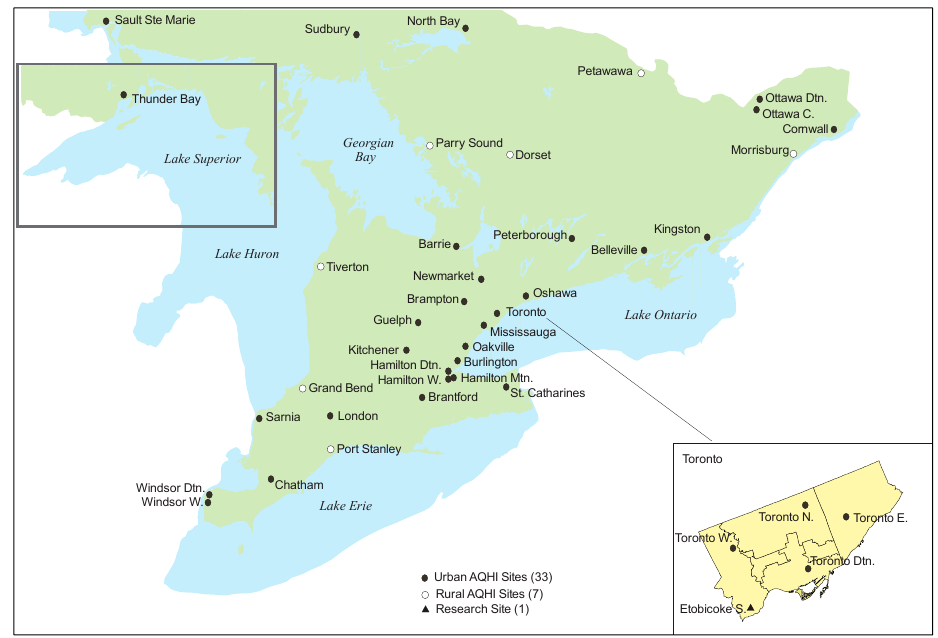
Figure 1. Ambient air monitoring stations across Ontario in 2013 (AQHI = Air Quality Health Index).